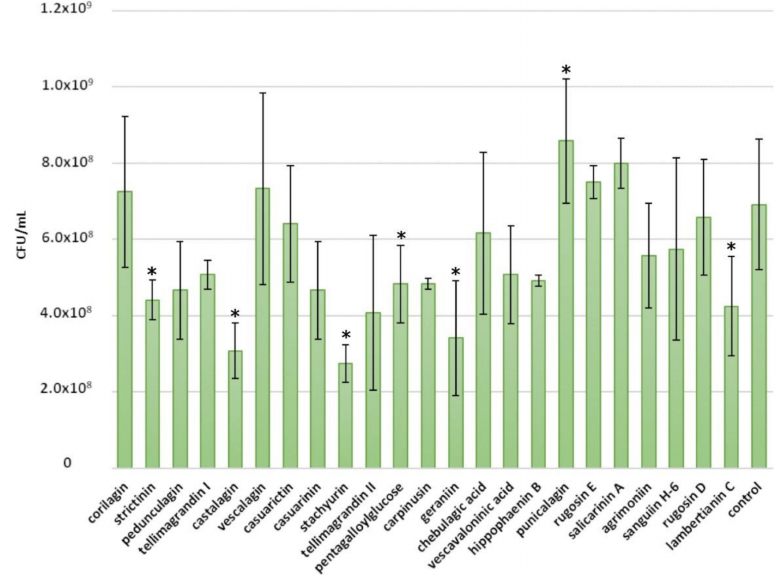
Figure 8. Growth of Lactobacillus plantarum after a 24 h treatment with 0.5 mM ellagitannin and pentagalloylglucose solutions. Growth is expressed as CFU / mL (mean values and standard deviations, n = 3); * p <